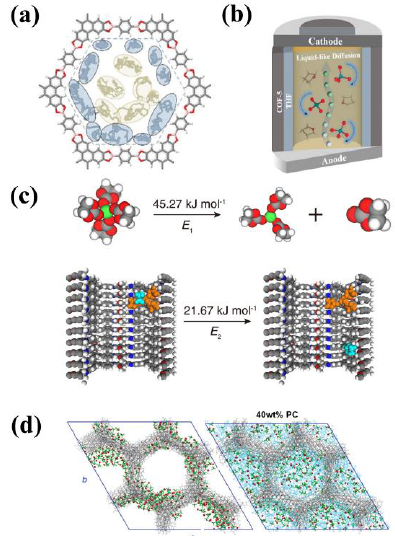
Figure 5. ( a ) Probability densities of the centers of THFs. Reproduced with permission from Ref. [44], Copyright (2019), Royal Society of Chemistry; ( b ) Schematic graphs of ion transport in COF − based SSEs; ( c ) DFT calculation model of Li(EC)4 + desolvation: in the pure liquid electrolyte and on the channel wall of TPB − DMTP − COF. Reproduced with permission from Ref. [45], Copyright (2020), Royal Society of Chemistry; ( d ) Snapshots at 200 ns for TAPB − PDA COF mixed with LiClO4 with 0 wt% and 40 wt% PC, Red spheres, green rods and cyan lines represent Li + , ClO4 − and PC molecules, respectively. Reproduced with permission from Ref. [46], Copyright (2022), Royal Society of Chemistry.